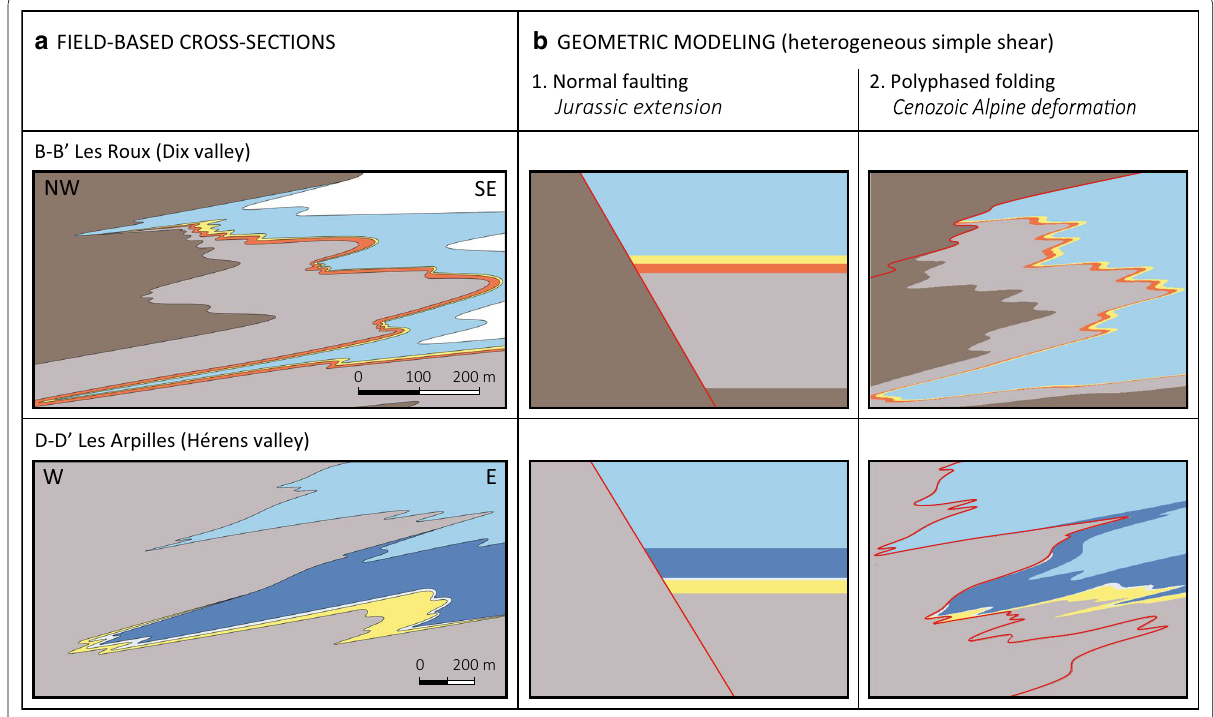
Fig. 14 Pre‑folding restoration of the cross‑sections of Figs. 8 and 10 by geometrical modeling. a Simplified cross‑sections B‑B’ and D‑D’ (Figs. 8 and 10). b Geometric models obtained by heterogeneous simple shear superimposed on an initial normal fault. Modeling performed with Shear2F software (Rey 2002). Model outputs are vertical cross‑sections through the 3D models. Detailed parameters of the applied deformations are given as Additional files (1 and 2). This demonstrates that the observed present‑day geometry can be obtained by folding on an initial